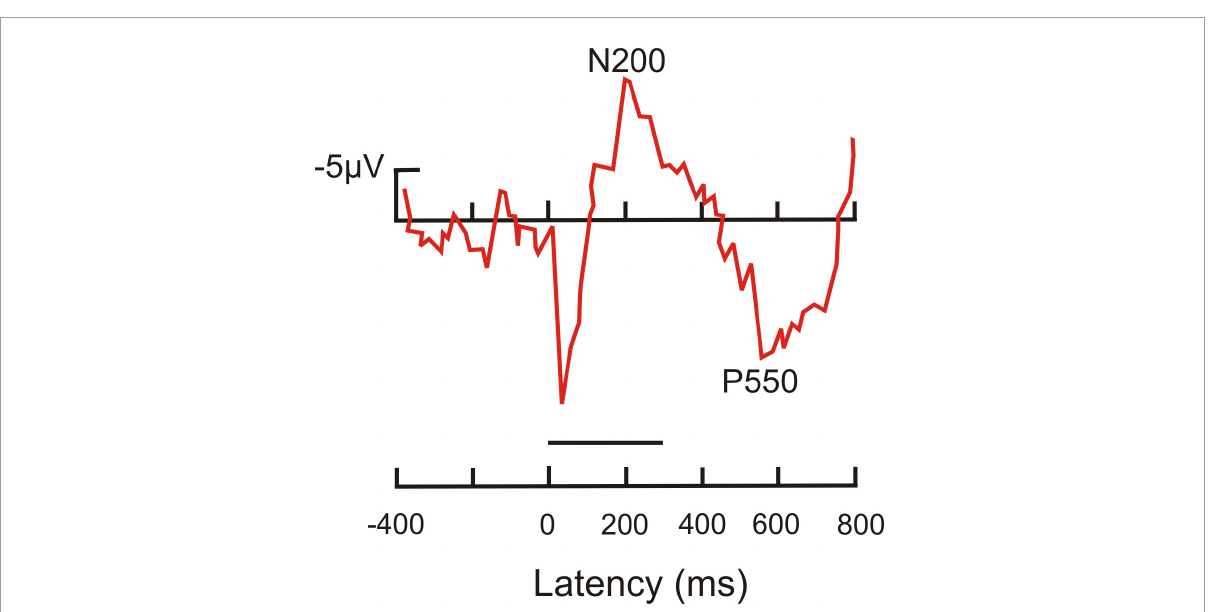
FIGURE5 Average ERP recorded from the head of a dolphin in response to a target tone. This tone had a duration of 300 ms (horizontal line above latency axis). It was followed by a second tone signaling conditioned access to a food reward. The ERP shows a prominent negativity peaking near 200 ms latency (N200) after tone onset, and a prominent positivity around 550 ms latency (P550). [Modified from Woods et al. (1986); their Figure 3.2 response to tone #3, target